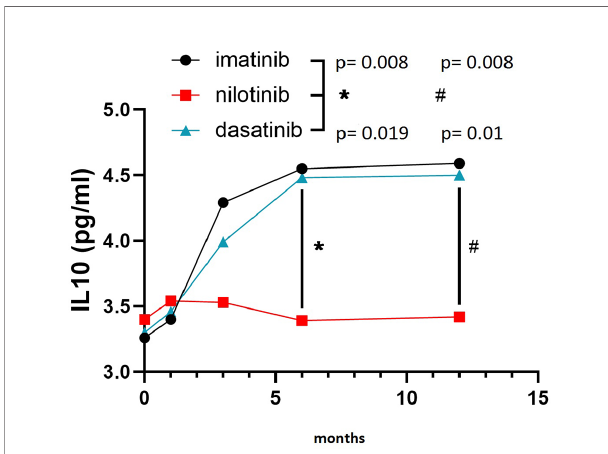
FIGURE 2 | IL10 levels in the three cohorts. Three-way ANOVA. IL10 levels were higher after 6 and 12 months of imatinib (F=5.530, p=0.008 and F=5.620, p=0.008, respectively) and dasatinib (F=4.160, p=0.019 and F=4.910, p=0.01, respectively) in comparison with nilotinib. Symbols "*" and “ # ” are referring to statistical differences reported with p values of IL10 levels at 6 (*) and 12 (#) months of treatment in imatinib and dasatinib groups compared to nilotinib.